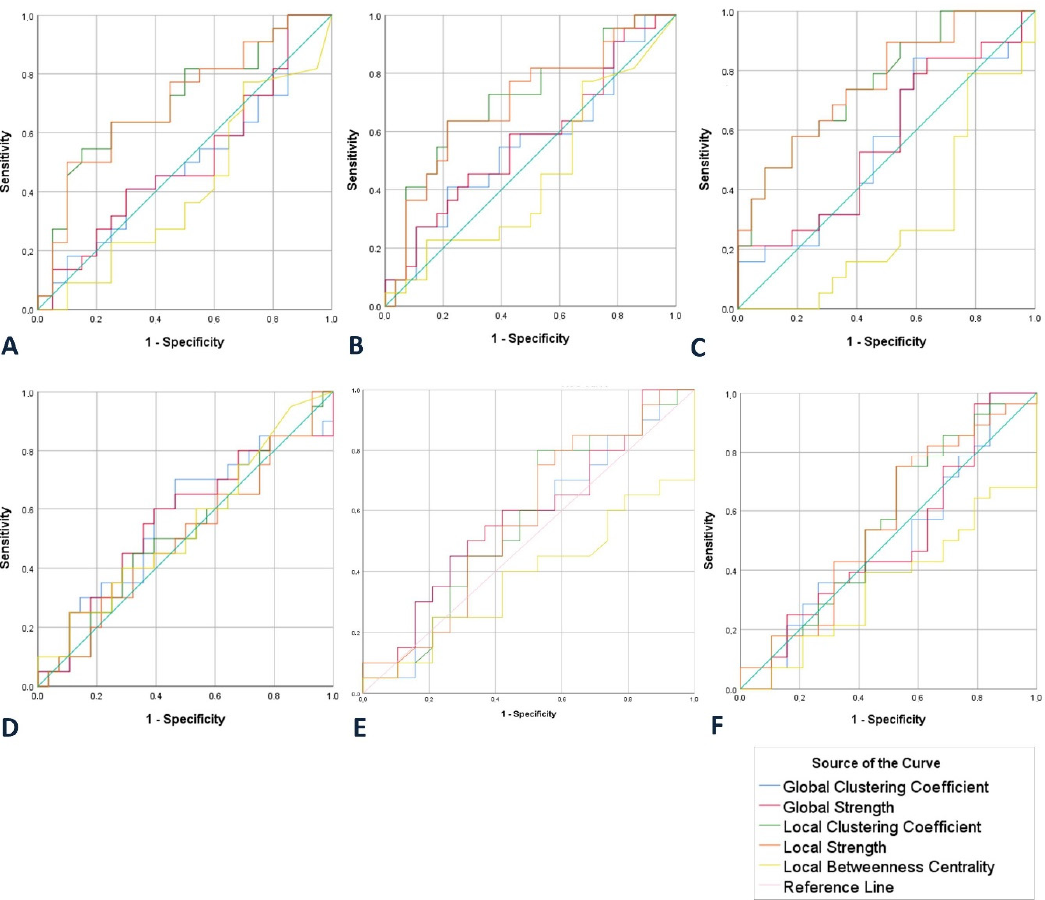
Figure 5. ROC curves showing the clustering coefficient, strength and betweenness centrality at local and global levels for discriminating between: ( A ) SCD and HC, ( B ) MCI and HC, ( C ) AD and HC, ( D ) MCI and SCD, ( E ) SCD and AD and ( F ) MCI and AD. Table 4. Sensitivity and specificity of clustering coefficient, strength and betweenness centrality at global and local levels for each group compared with one of the other three groups.